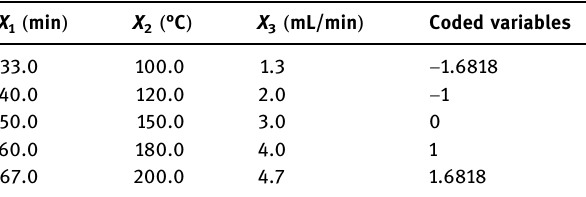
Figure 1: Schematic diagram of the SWE apparatus. Table 1: Coded and uncoded levels of the independent variables used in the RSM design